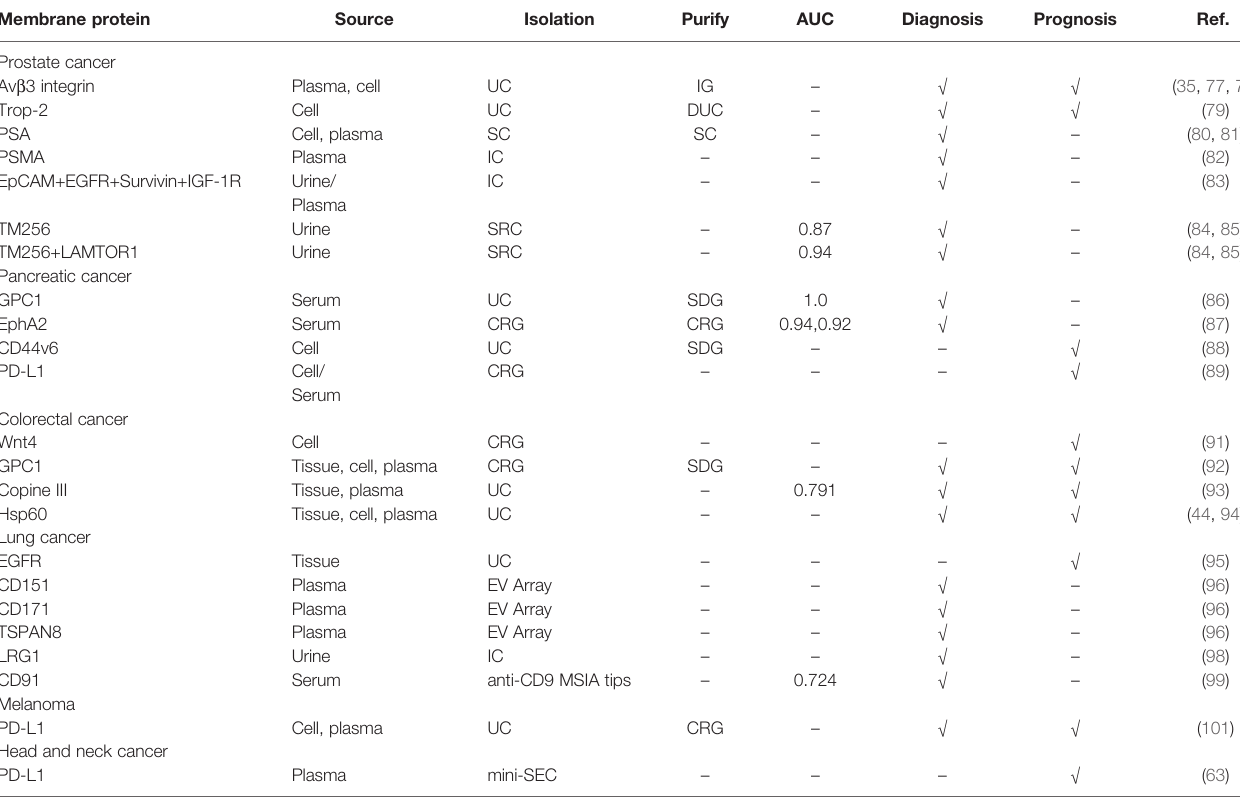
TABLE 3 | sEV membrane proteins as biomarkers for